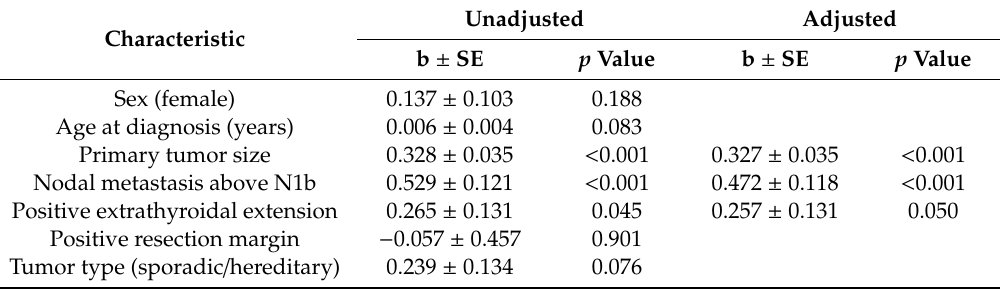
Table 2. Linear regression analysis of preoperative serum calcitonin (pg / mL, log-transformed) and the indicated